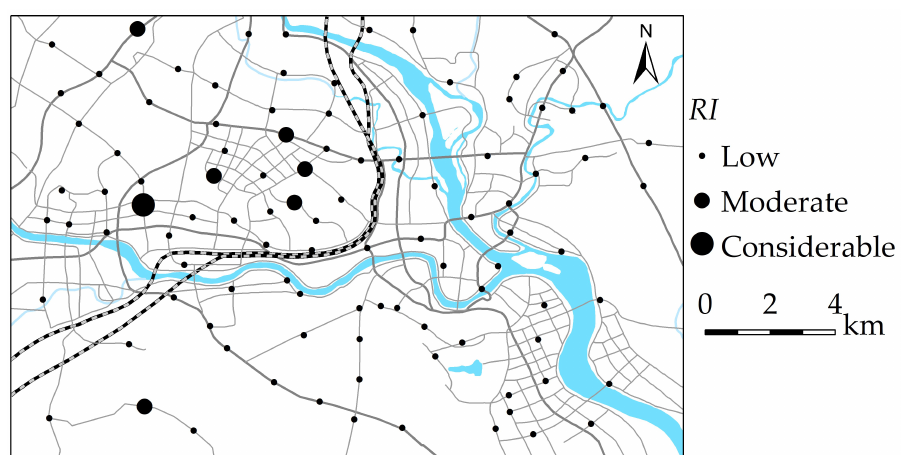
Figure 5. The RI degree of HMs in Mianyang urban area.